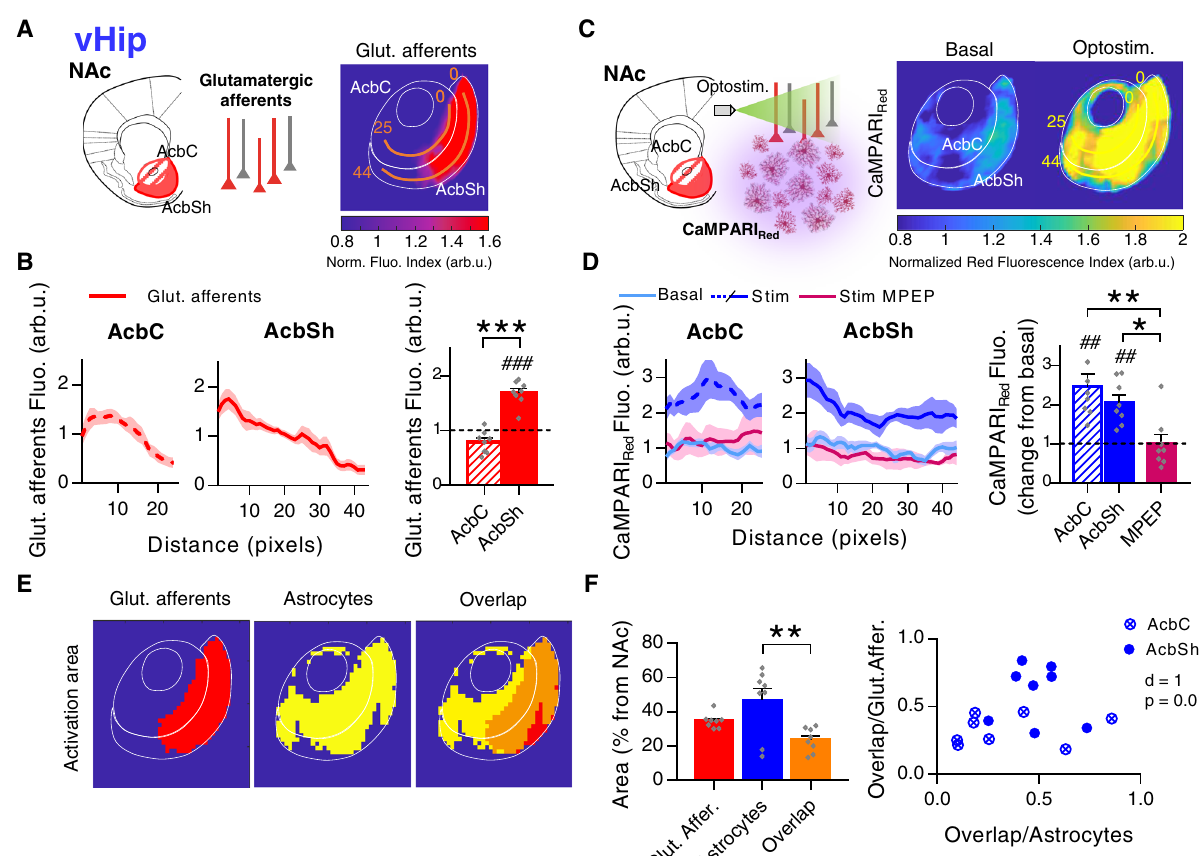
Fig. 7 | Spatial nucleus accumbens (NAc) astrocytic response to ventral hip- pocampus (vHip) afferents. A Left, scheme of opsin-transfected vHip afferents in the NAc. Right, average PRQ image showing vHip glutamatergic innervation pat- tern. Orange lines starting from pixel 0 in each subregion were used for quanti fi - cation(pixel=50 µ m 2 ). B Left,glutamateafferents fl uorescence(arb.u.)vsdistance (pixels)quantifying vHip innervation across orangelines. Right, average glutamate afferents spatial fl uorescence (arb.u.) in the accumbens core (AcbC; slashed bar) and accumbens shell (AcbSh; solid bar) (8 slices, 6 mice). One-sample t test, ### P <0.001; two-tailed unpaired t test, *** P <0.001. C Left, scheme of astrocytic Ca 2+ activity, measured by CaMPARI GFAP red, in response to vHip afferent ’ s optos- timulation. Right, average PRQ image showing astrocytic activation pattern in the NAc in basal and optostimulated conditions. Yellow lines starting from pixel 0 in each subregion were used for quanti fi cation (pixel=50 µ m 2 ). D Left, CaMPARI Red fl uorescence (arb.u.) vs distance (pixels) quantifying astrocytic activation across yellow lines. Right, relative average CaMPARI Red spatial fl uorescence (arb.u.) in